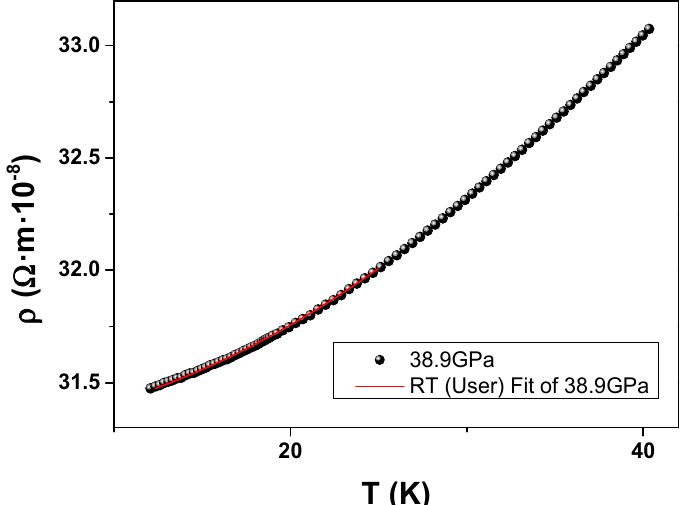
Figure 7. The fitting curve of te normal-state conductivity of La at high pressure in terms of the power law format ρ ( T ) = ρ 0 + AT n .